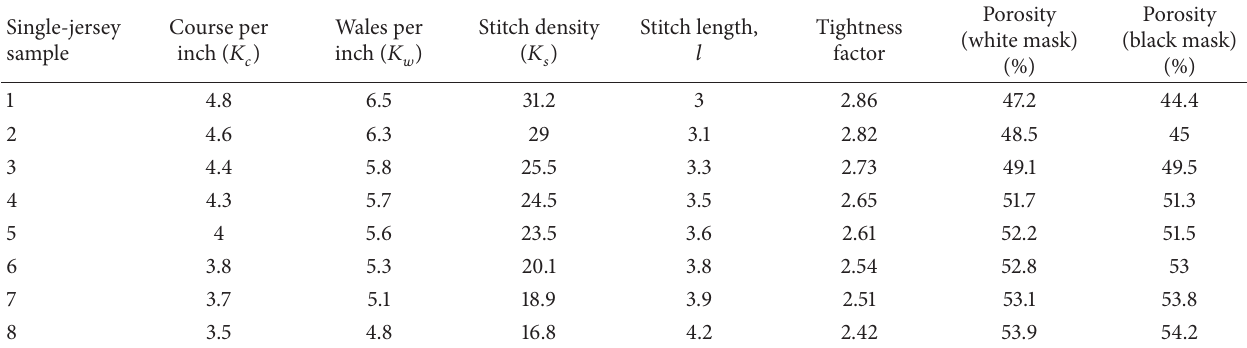
Table 3: Results of fabric structural parameters and image analysis pixel count and percentage of void values of single-jersey fabric (CKM